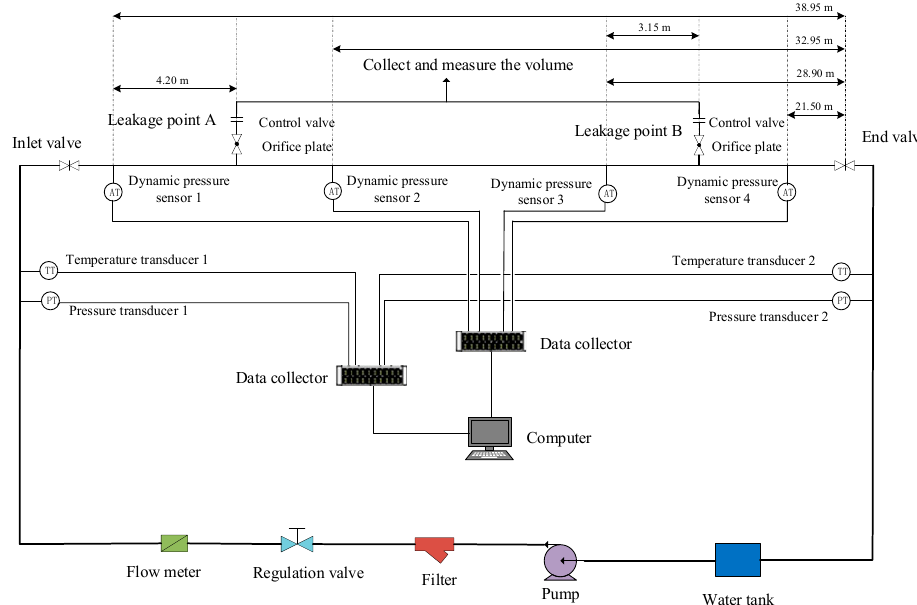
Figure 6. Flow chart of the indoor circulating leak detection experiment.